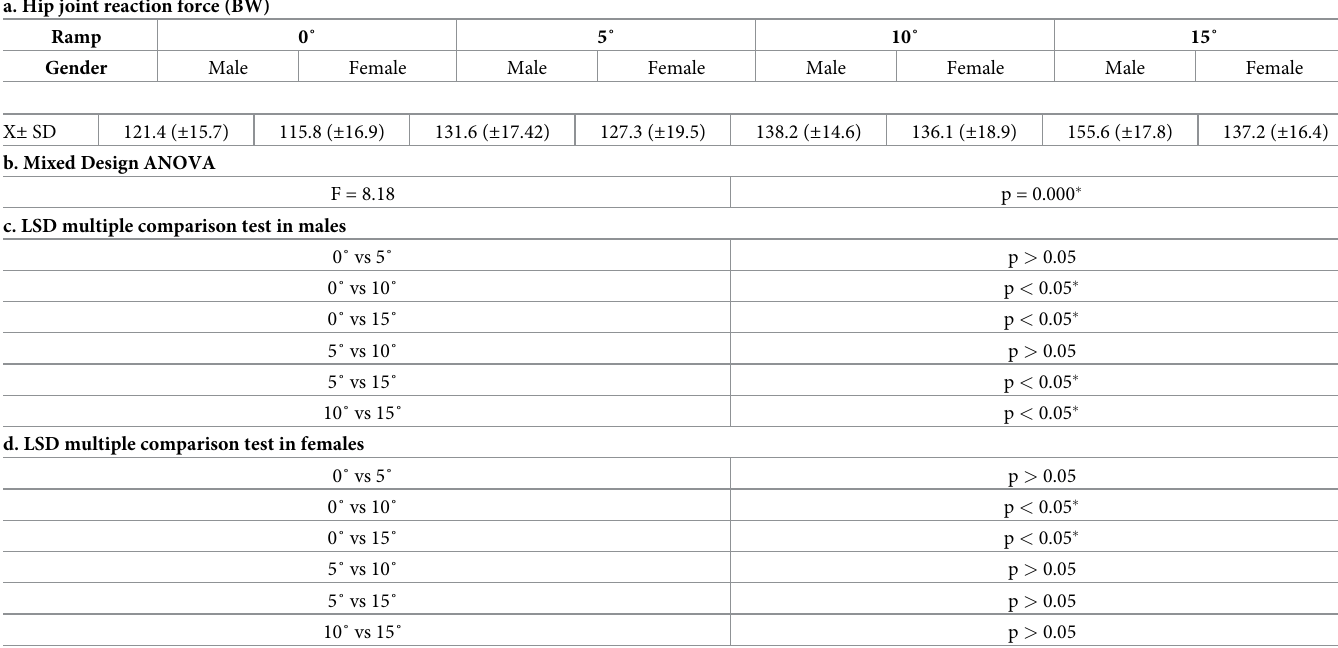
Table 2. The table demonstrates the (a) descriptive statistics for the interaction between ramps and gender on the mean values of the resultant hip JRF while walk- ing up ramps as a multiple of body weight (BW), (b) Mixed Design MANOVA for the resultant hip joint reaction force of males and females during single-limb sup- port on the four walking ramps (0˚, 5˚, 10˚, 15˚). Calculation of least significant difference (LSD) in (c) males and in (d)